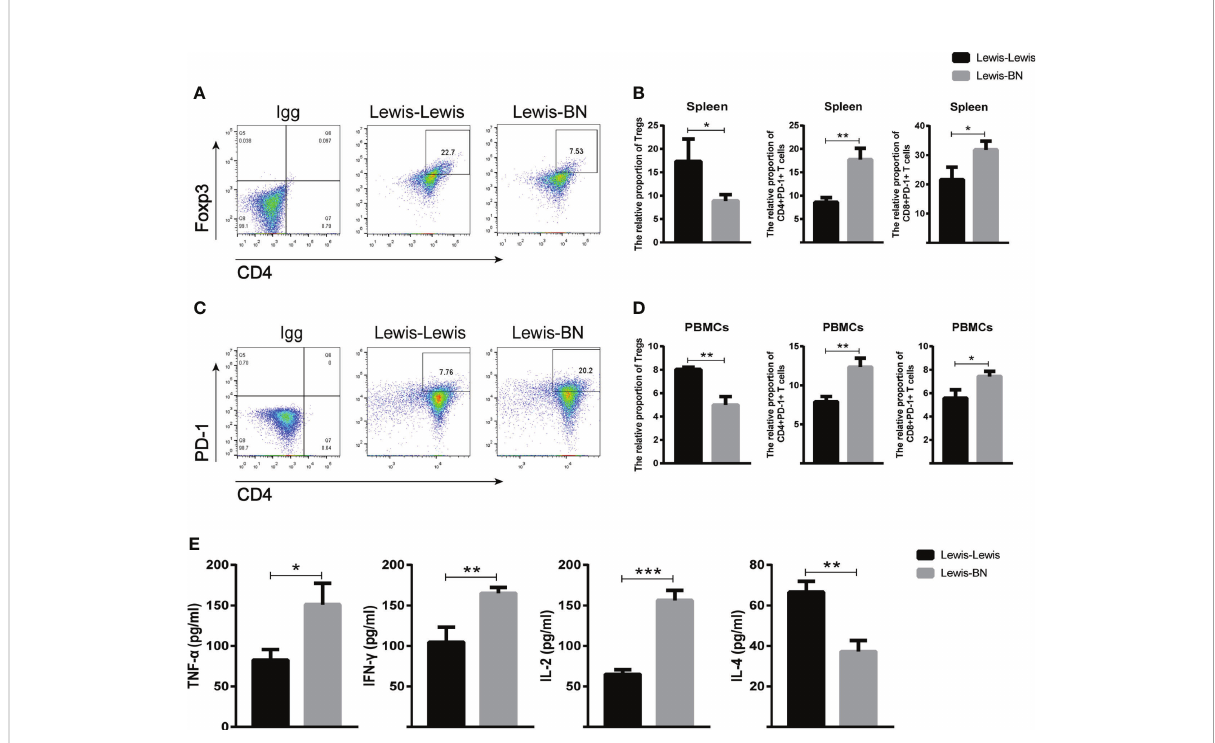
FIGURE 6 (A – D) Spleen and peripheral blood of recipient rats in each group was collected on POD 7. The content of CD4+Foxp3+, CD4+PD-1, CD8+PD- 1 T cells were detected by fl ow cytometry. (E) The serum levels of TNF- b , IFN- g , IL -2 and IL-4 in each group was detected on POD 7. *P<0.05, **P < 0.01, ***P <